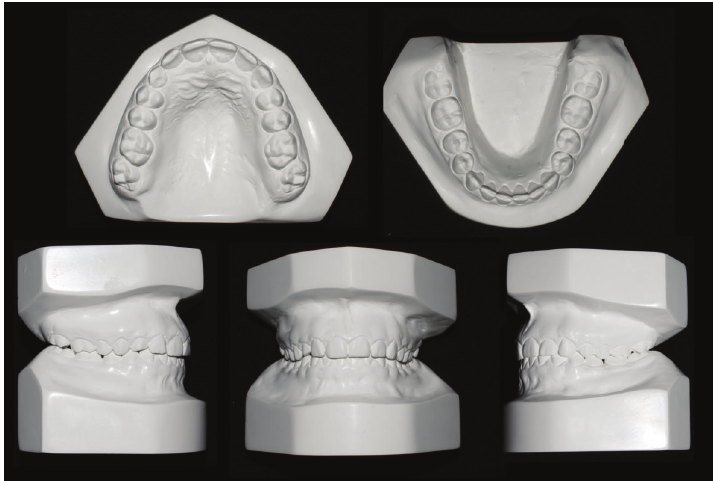
Figure 2: Initial documentation: study models showing a suitable arch shape and a good occlusal